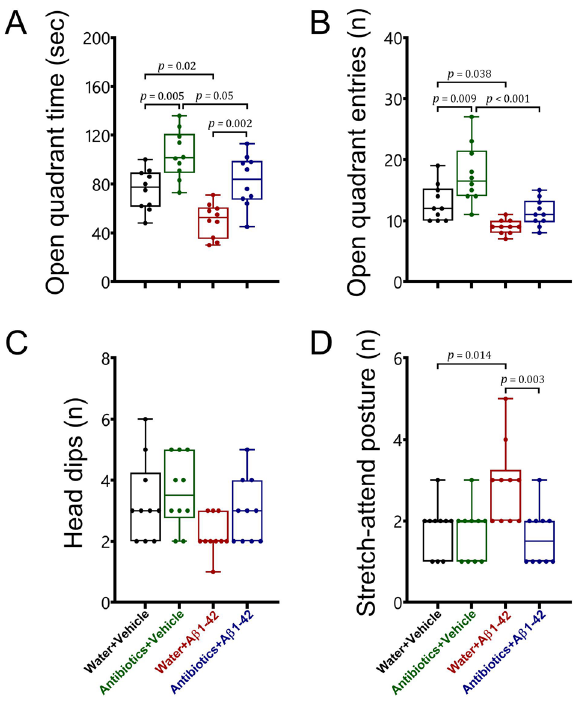
Figure 3. The effects of antibiotic treatment alone or in combination with Aβ1–42 treatment on anxiety- related behaviour in male C57BL6 mice. To evaluate anxiety-related behaviour, animals were subjected to the zero maze ( A open quadrant time; B open quadrant entries; C head dips; D stretch-attend posture). Data are expressed as mean ± SEM (n = 10). Antibiotic-treated mice exhibited a significant increase in the open quadrant time [ p = 0.005] and entries [ p = 0.009], while no alterations [ p > 0.05] were found in the head dips and stretch- attend postures following antibiotic treatment, as compared to the water + vehicle group. On the other side, Aβ 1–42 injection significantly decreased the time spent [ p = 0.02] and the number of entries [ p = 0.038] in the open quadrants and increased the stretch-attend postures [ p = 0.014] in water-treated mice in